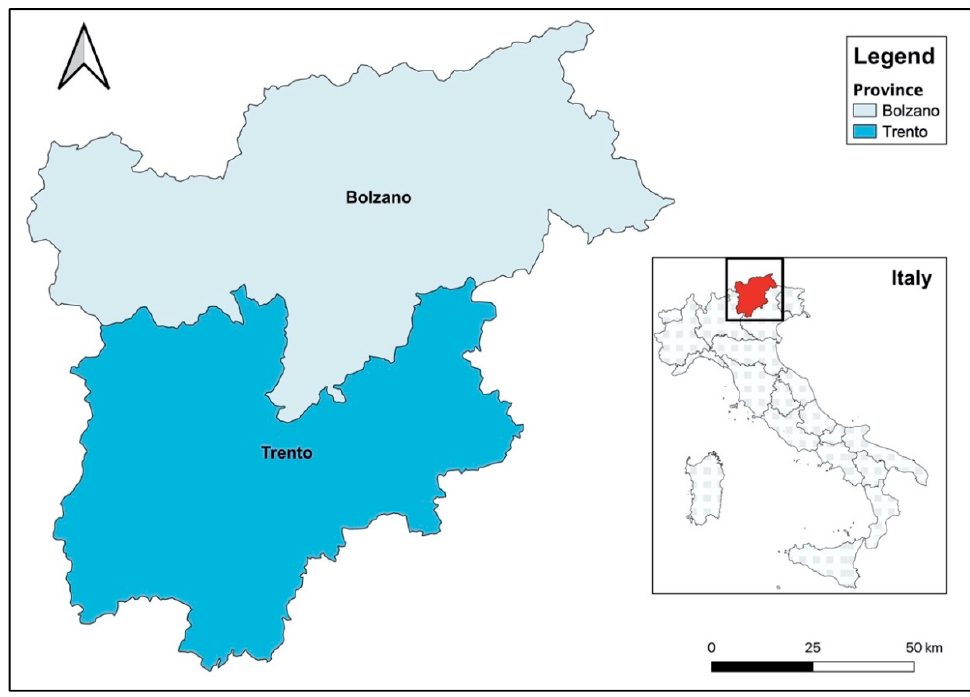
Figure 1. The study